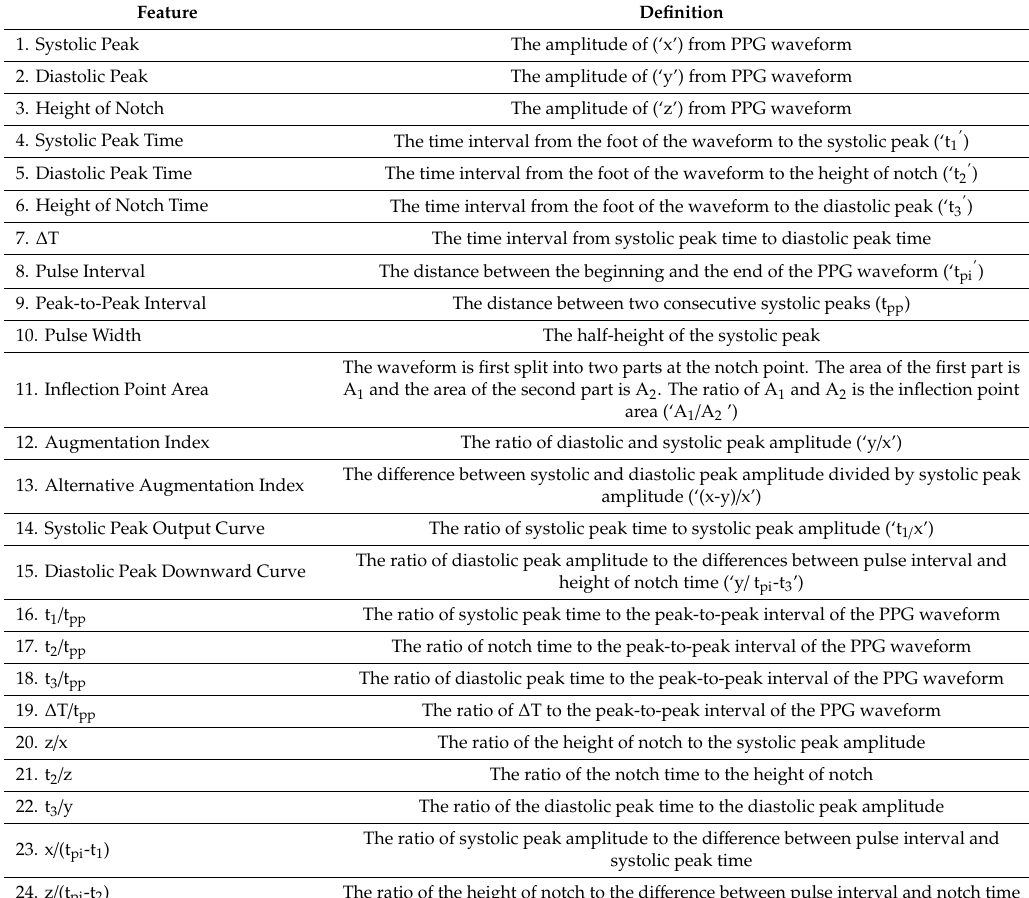
Table 2. Twenty-four features from the PPG